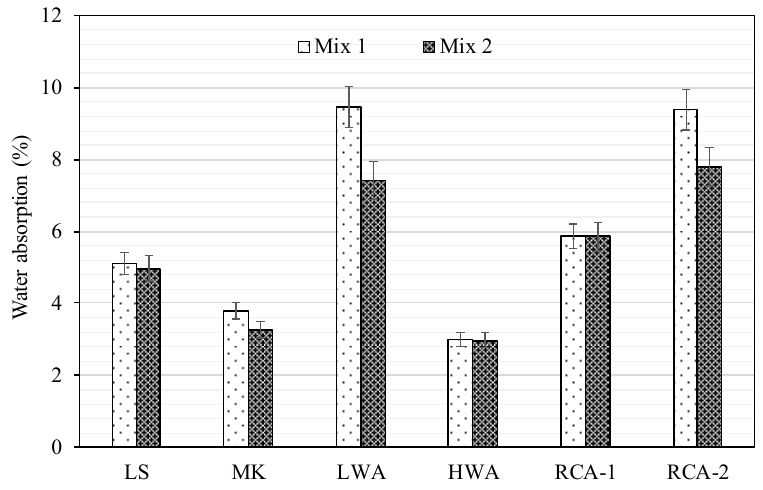
Figure 9. Water absorption of concrete for Mix 1 and Mix 2.